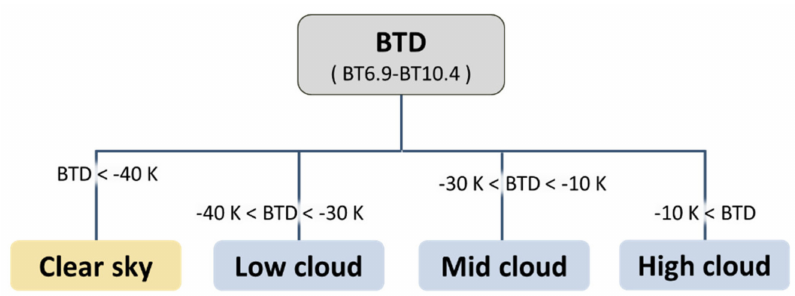
Figure 3. Illustration of the cloud classification